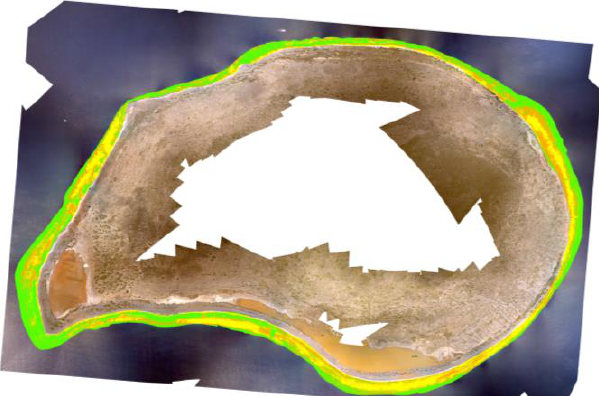
Figure 5. Coral reef map of Klein Bonaire island